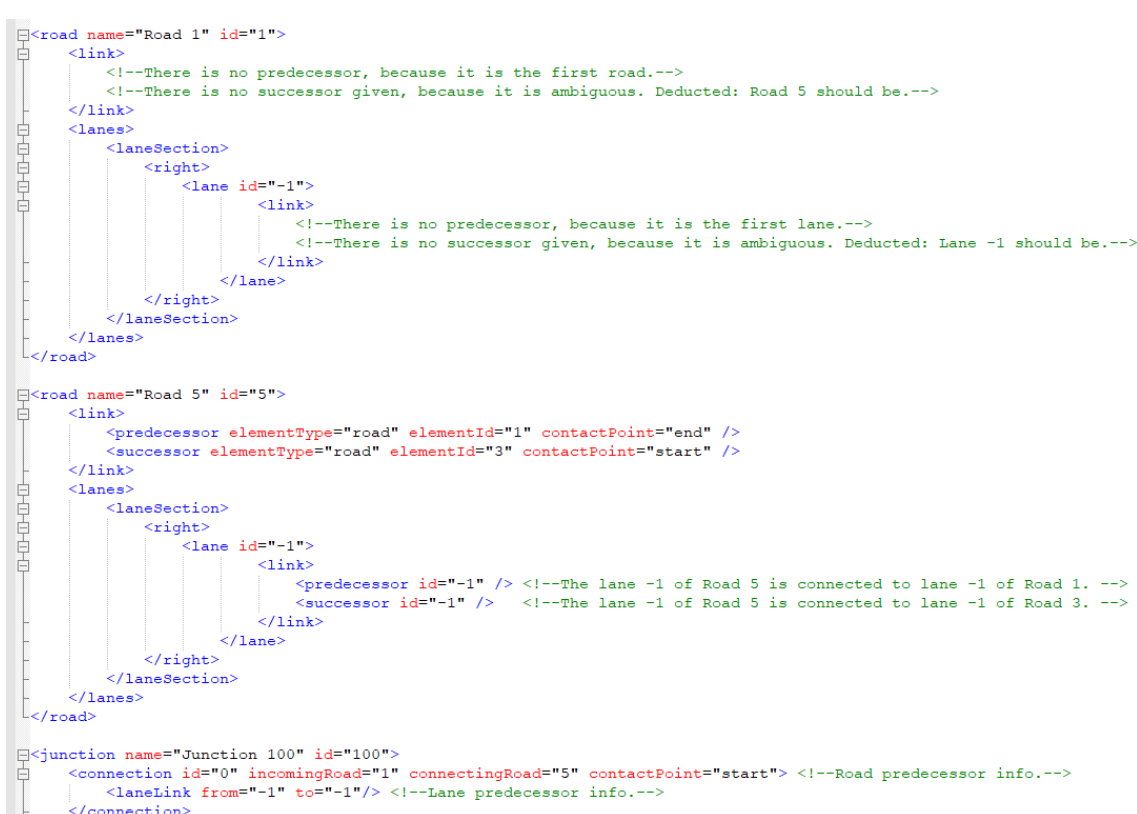
Figure 7. XML code-snippet for Road1 and Road5 as well as their junction